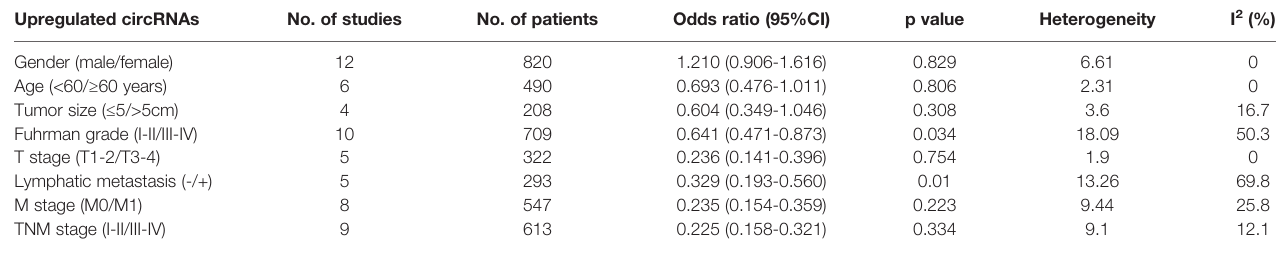
TABLE 3 | Correlation between circRNAs and clinicopathological features of RC. Upregulated